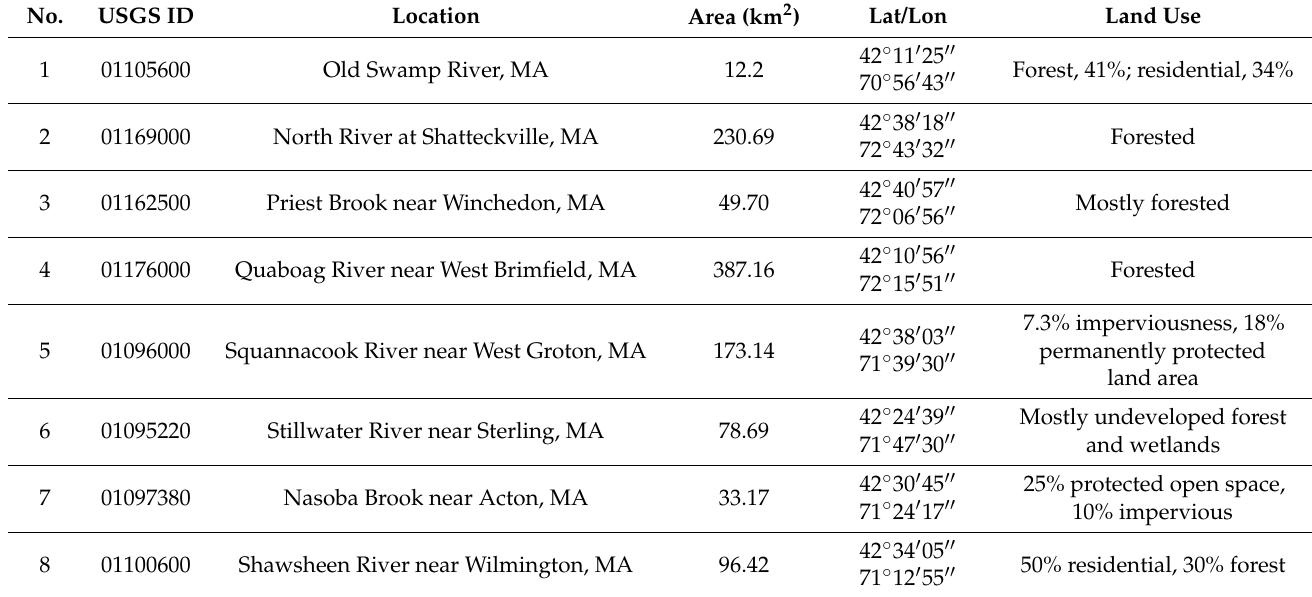
Table 1. Descriptions of selected watersheds within northeastern region of the United States